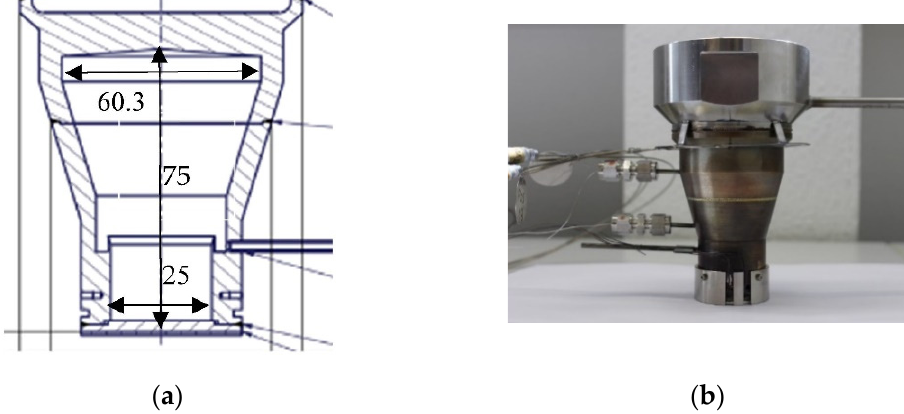
Figure 5. HPEE mock-up: ( a ) cross-section through the mock-up with dimensions; ( b ) photograph of the HPEE mock-up. Table 3. Parameters of HPEE body.